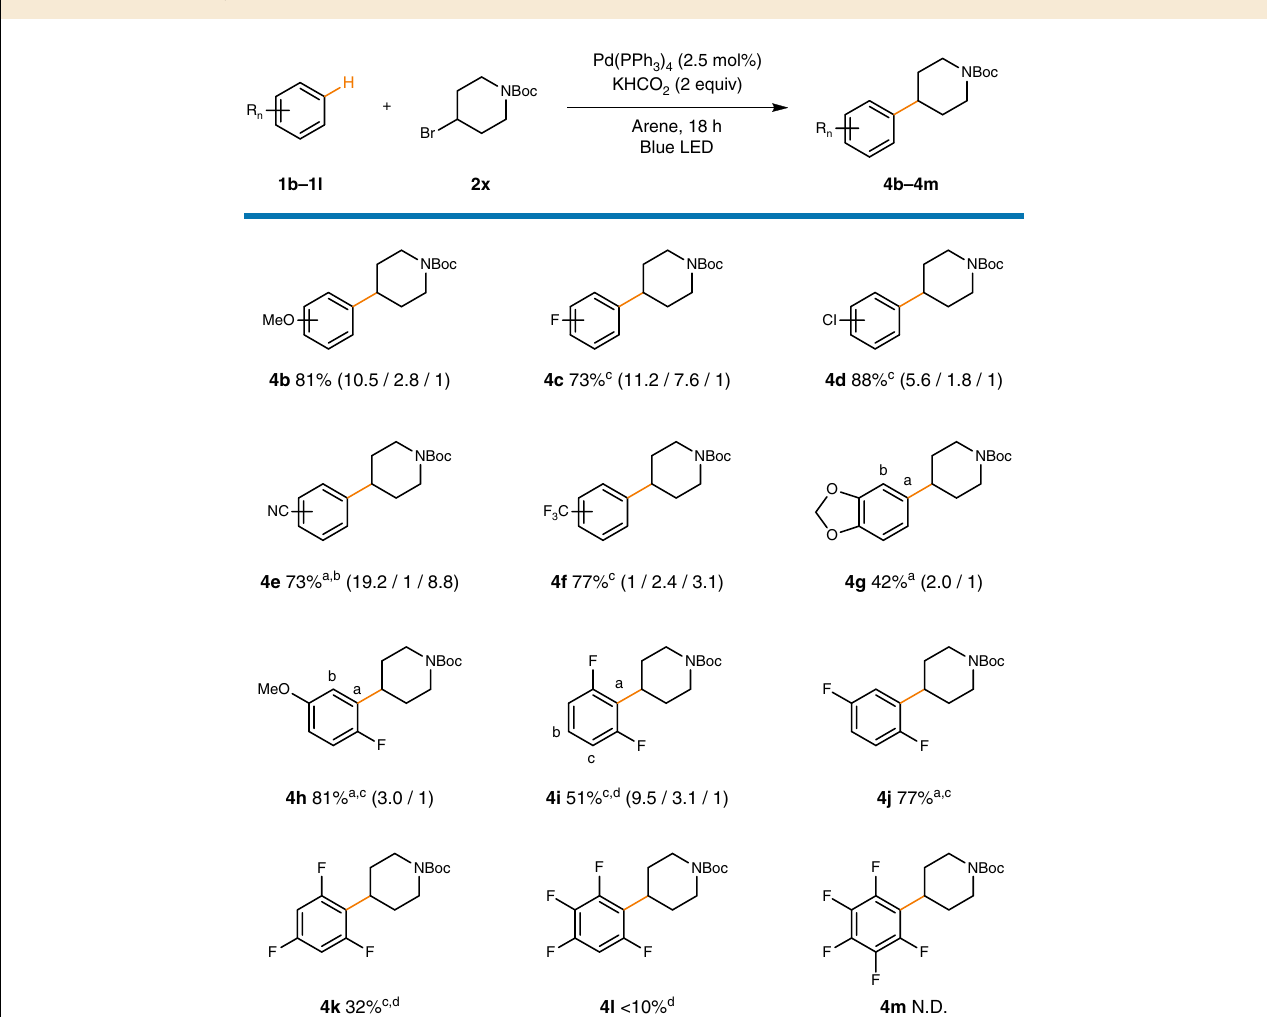
Table 4 Substrate scope of